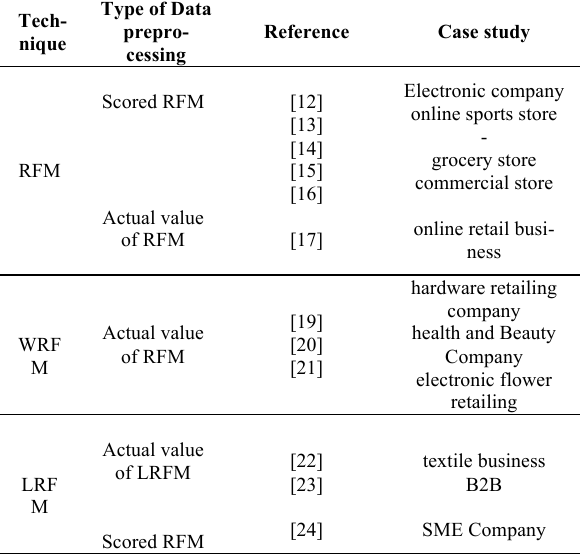
TABLE I. TYPE OF DATA PREPROCESSING ACCORDING TO